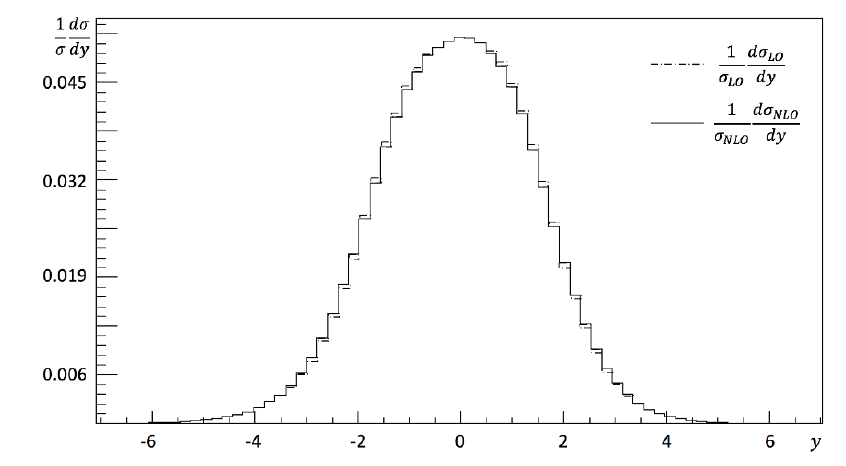
Figure 8 . Di(cid:11)erential cross-section for coloron pair production in terms of rapidity at LO and p NLO accuracy, for s = 14 TeV, mass M = 1 TeV, and (cid:22) = (cid:22) F = M . can see from the (cid:12)gure, the e(cid:11)ect of the NLO corrections results in a slight